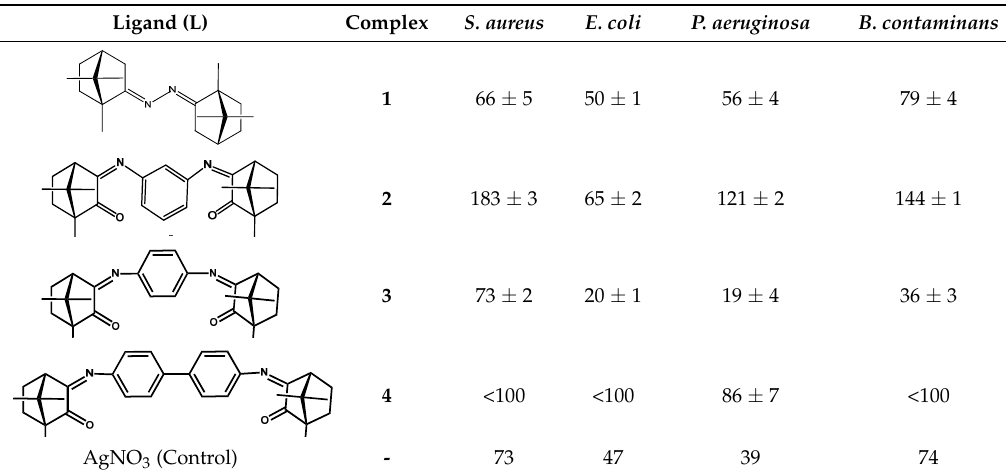
Table 1. Minimal inhibitory concentration (MIC) values calculated for complexes [Ag(NO 3 )L], in μ g/mL, towards the bacterial strains Staphylococcus aureus Newman, E scherichia coli ATCC25922, Pseudomonas aeruginosa 477, and Burkholderia contaminans IST408. Data taken from